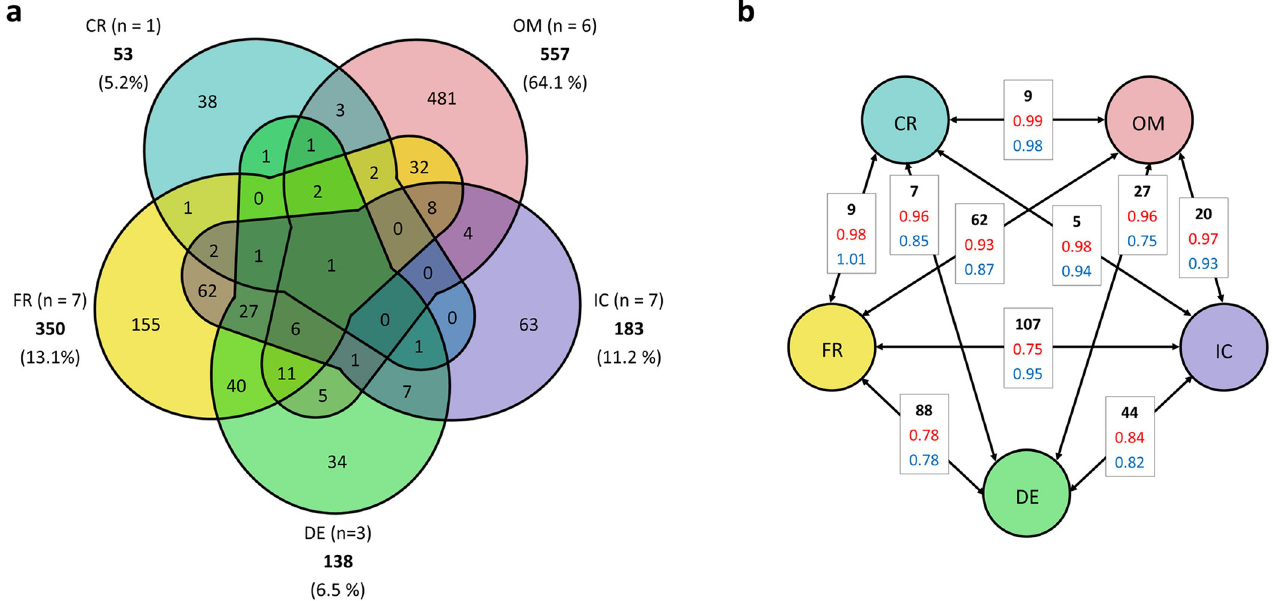
Fig 5. Beta diversity estimates for summarized groups per location. (a) VENN diagram based on shared richness, calculated based on a presence/absence matrix summarizing all samples per location. Number of included samples (n), total OTU numbers and percentage of total sequence numbers were shown per location. (b) Beta diversity estimates of paired location groups showing numbers of shared OTUs (black), Jaccard dissimilarity coefficients (red) and phylogenetic beta diversity (MPD between samples, blue). IC = Iceland, DE = Germany, FR = France, CR = Croatia, OM = Oman.